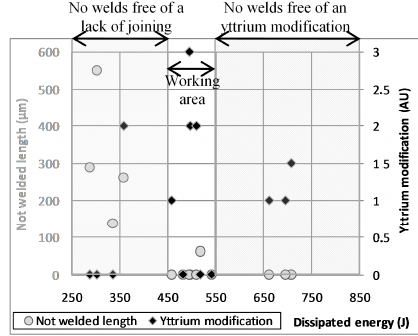
Figure 11. Range of the allowable dissipated energy to achieve welds with no lack of joining and no yttrium modifications ( C s = 0.2